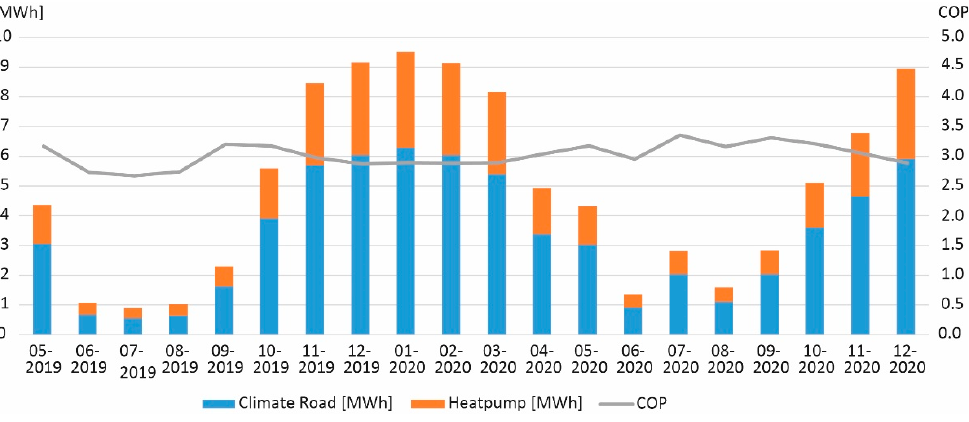
Figure 6. Energy produced and COP values from the Climate Road.